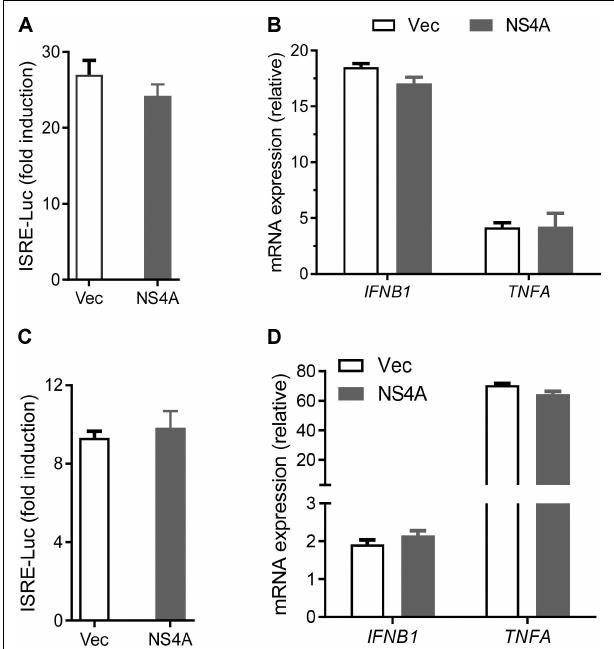
FIGURE 3 | NS4A does not interfere with TLR3 or TLR4 signaling. (A) Quantification of ISRE-Luc activity in HEK293T cells transfected with Myc vector + FLAG-TLR3 or Myc-NS4A + FLAG-TLR3 (100 ng each) for 16 h and then stimulated with 20 µ g/ml low molecular weight polyI:C-L (no transfection) for 24 h. (B) Quantification of IFNB1 and TNFA mRNA by qPCR. The cells were treated similarly as in A except that polyI:C stimulation was 8 h. (C) Quantification of ISRE-Luc activity in stable TLR4/MD2/CD14-expressing HEK293 cells transfected with 100 ng of Myc vector or Myc-NS4A plasmid for 12 h and stimulated with 100 ng/ml of LPS for 24 h. (D) Quantification of IFNB1 and TNFA mRNA by qPCR. The cells were treated similarly as in C except that LPS stimulation was 8 h. The results are expressed as fold change over unstimulated cells. The bars represent the mean + SEM of the results, n = 3. Three biological replicates were pooled for qPCR. ∗ p < 0.0.5; ∗∗ p < 0.01 (Student’s t -test). The data shown are representative of three independent